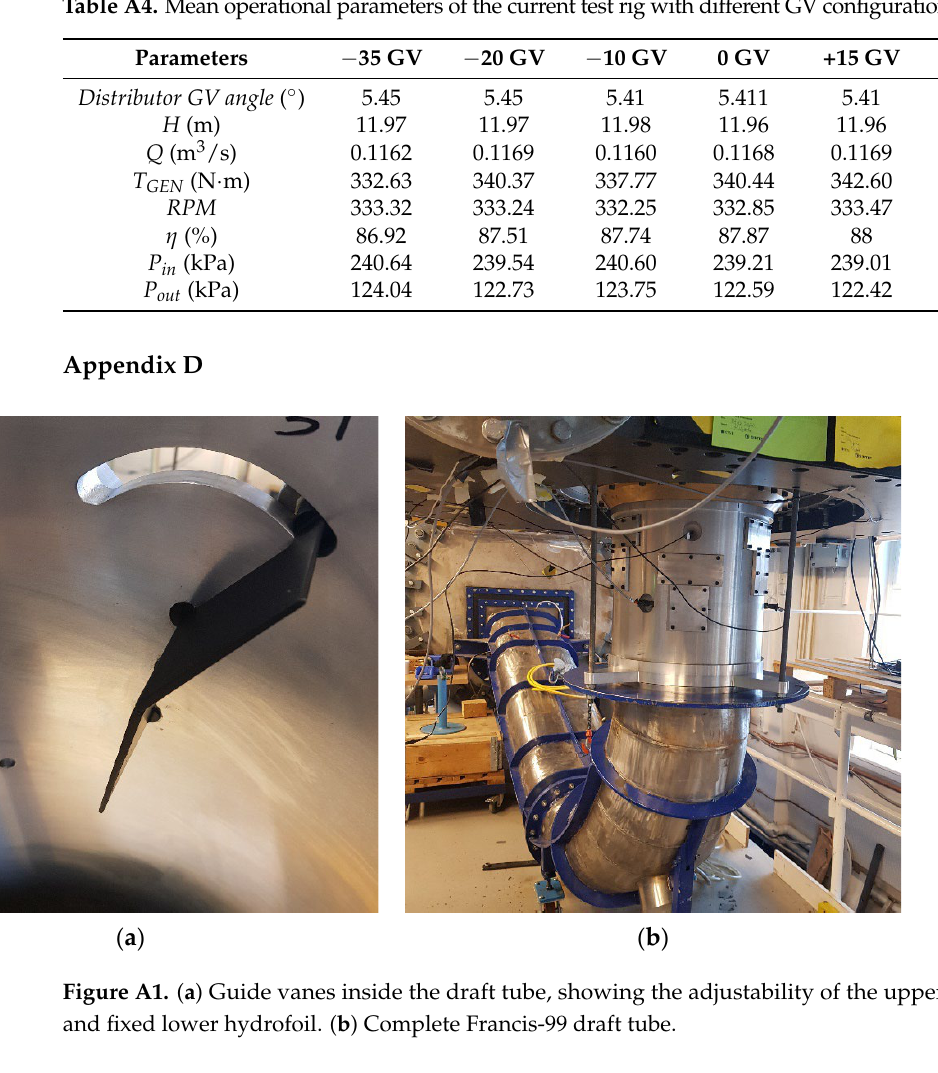
Table A4. Mean operational parameters of the current test rig with different GV configurations at PL1.